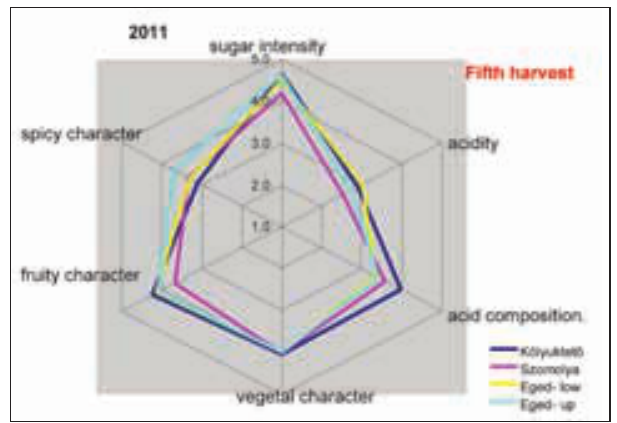
Figure 2e: Main sensorial characters of the pulp (2010-2011- Fifth harvest